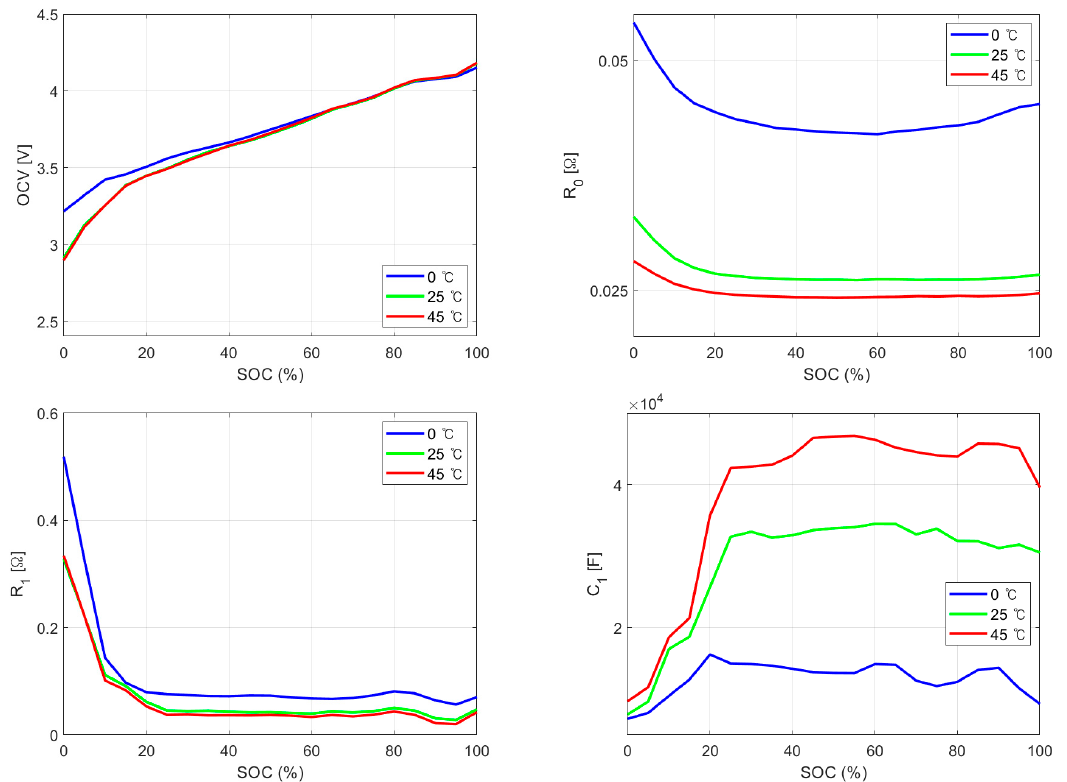
Figure 2. Battery parameter obtained for first-order RC circuit according to operating